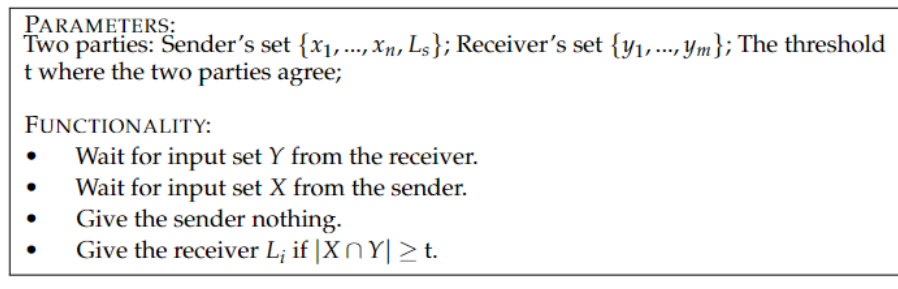
Figure 1. The functionality of set threshold label private set